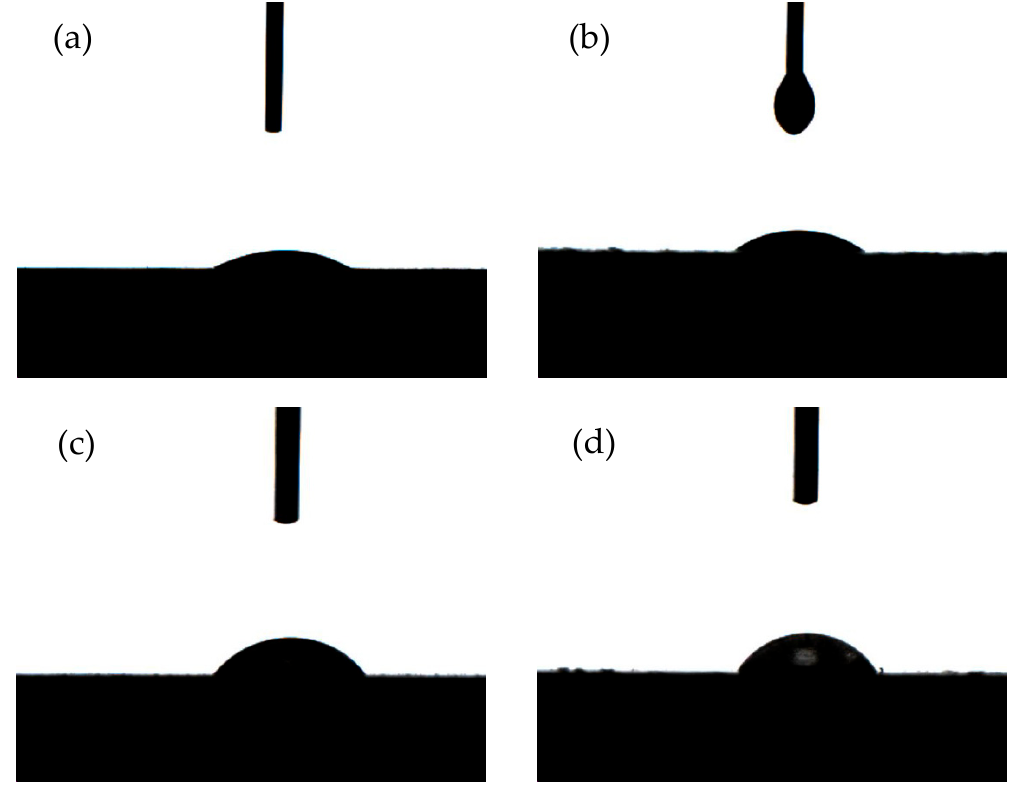
Figure 6. Contact angles of oak sample. ( a ) Pure oak with water; ( b ) pure oak with 70 wt% PUA droplet; ( c ) 12 g/m 2 PUA coated oak with water; ( d ) 60 g/m 2 PUA coated oak with water. Table 5. Contact angles of PUA droplets (70% solids) and water on the oak surface.